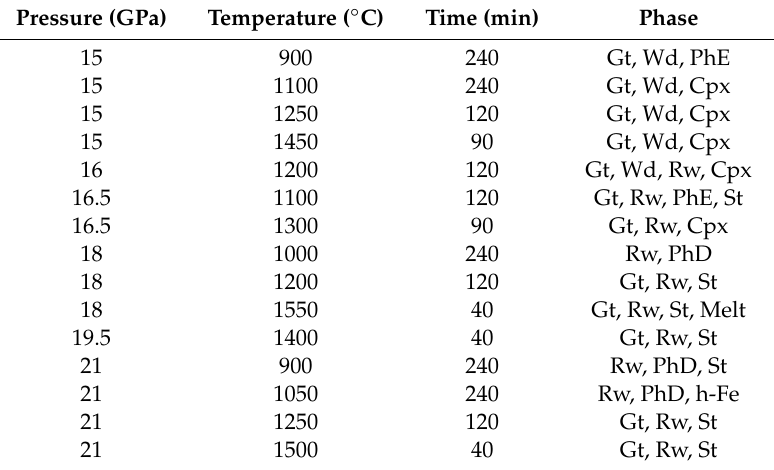
Table 2. Experimental conditions and